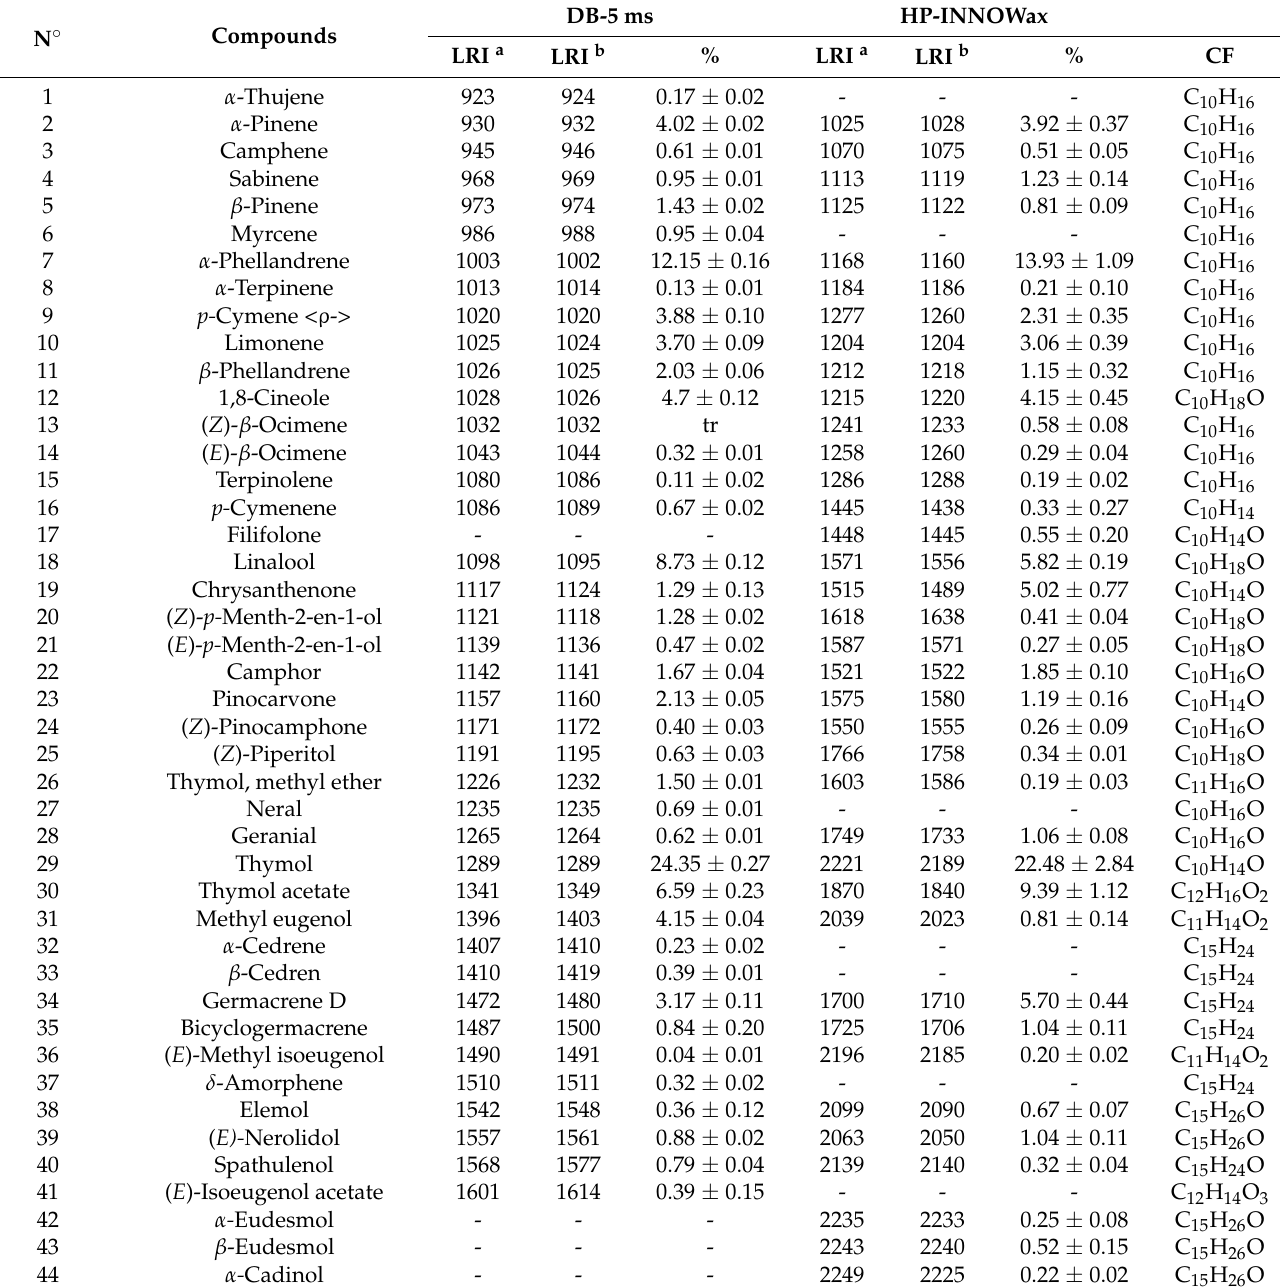
Table 1. Chemical compounds present in the essential oil of the leaves of H.